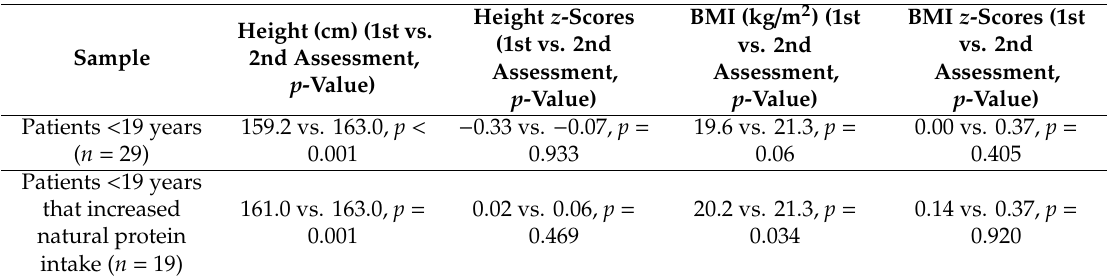
Table 4. Growth in subjects with PKU aged < 19